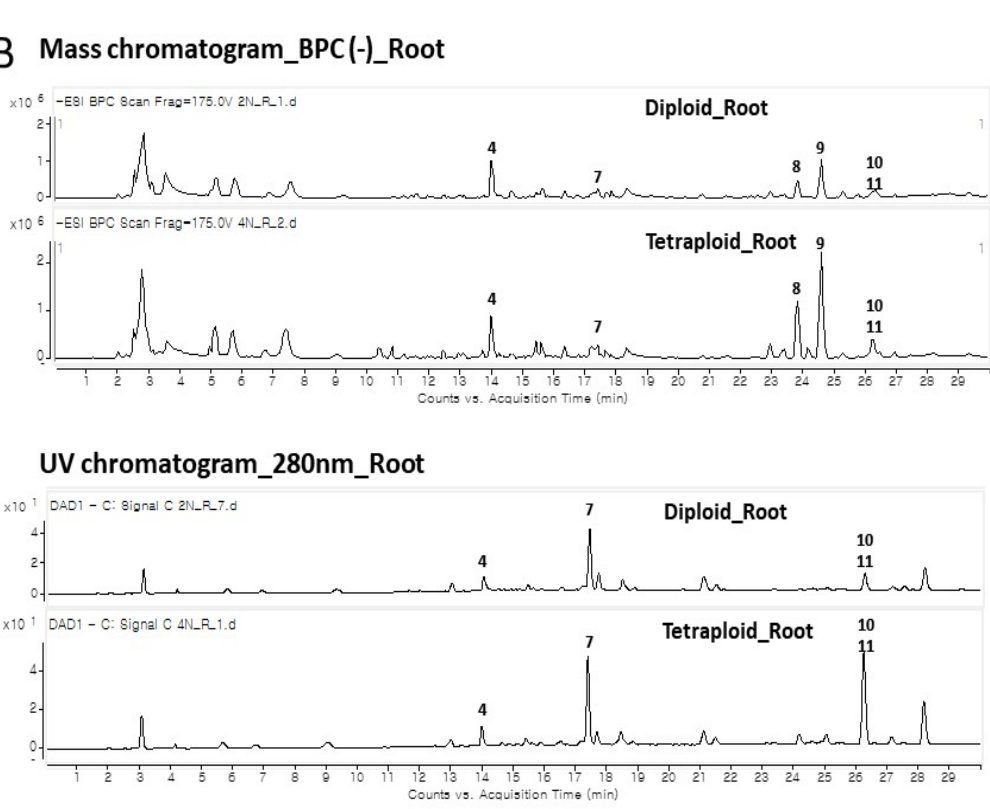
Figure 6. LC–MS profiles of the methanol extracts of the leaves ( A ) and roots ( B ) of 6-month-old diploid and tetraploid (line 81-12) C. officinale plants. Samples were analyzed in the negative ion mode. Peak numbers are described in Table 4.